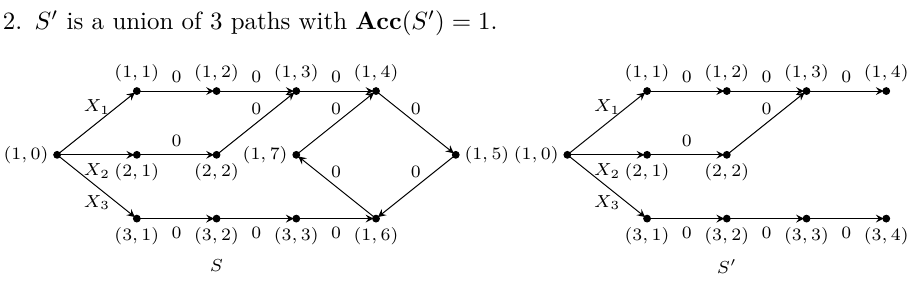
Figure 4: Unicycles and union of